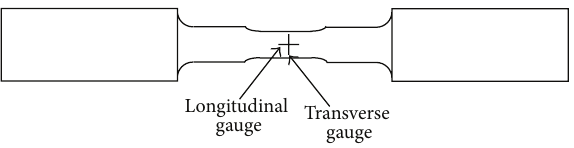
Figure 4: Positions of the virtual longitudinal and transversal strain gauges.